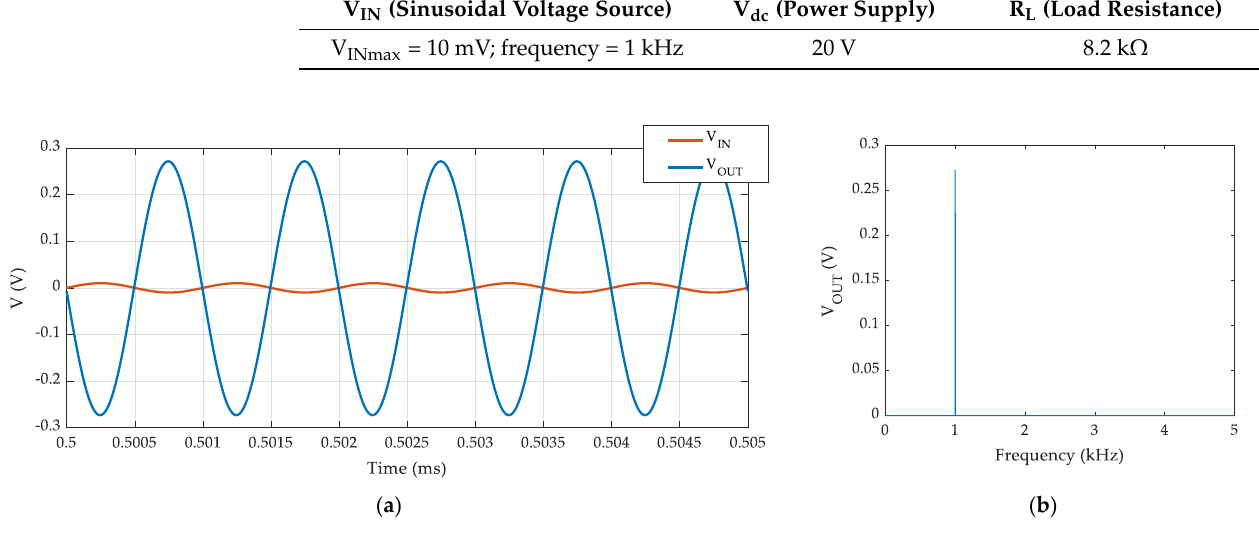
Table 2. Values of the load resistance and the voltage sources of the circuit. V IN (Sinusoidal Voltage Source) V dc (Power Supply) R L (Load Resistance) V INmax = 10 mV; frequency = 1 kHz 20 V 8.2 kΩ